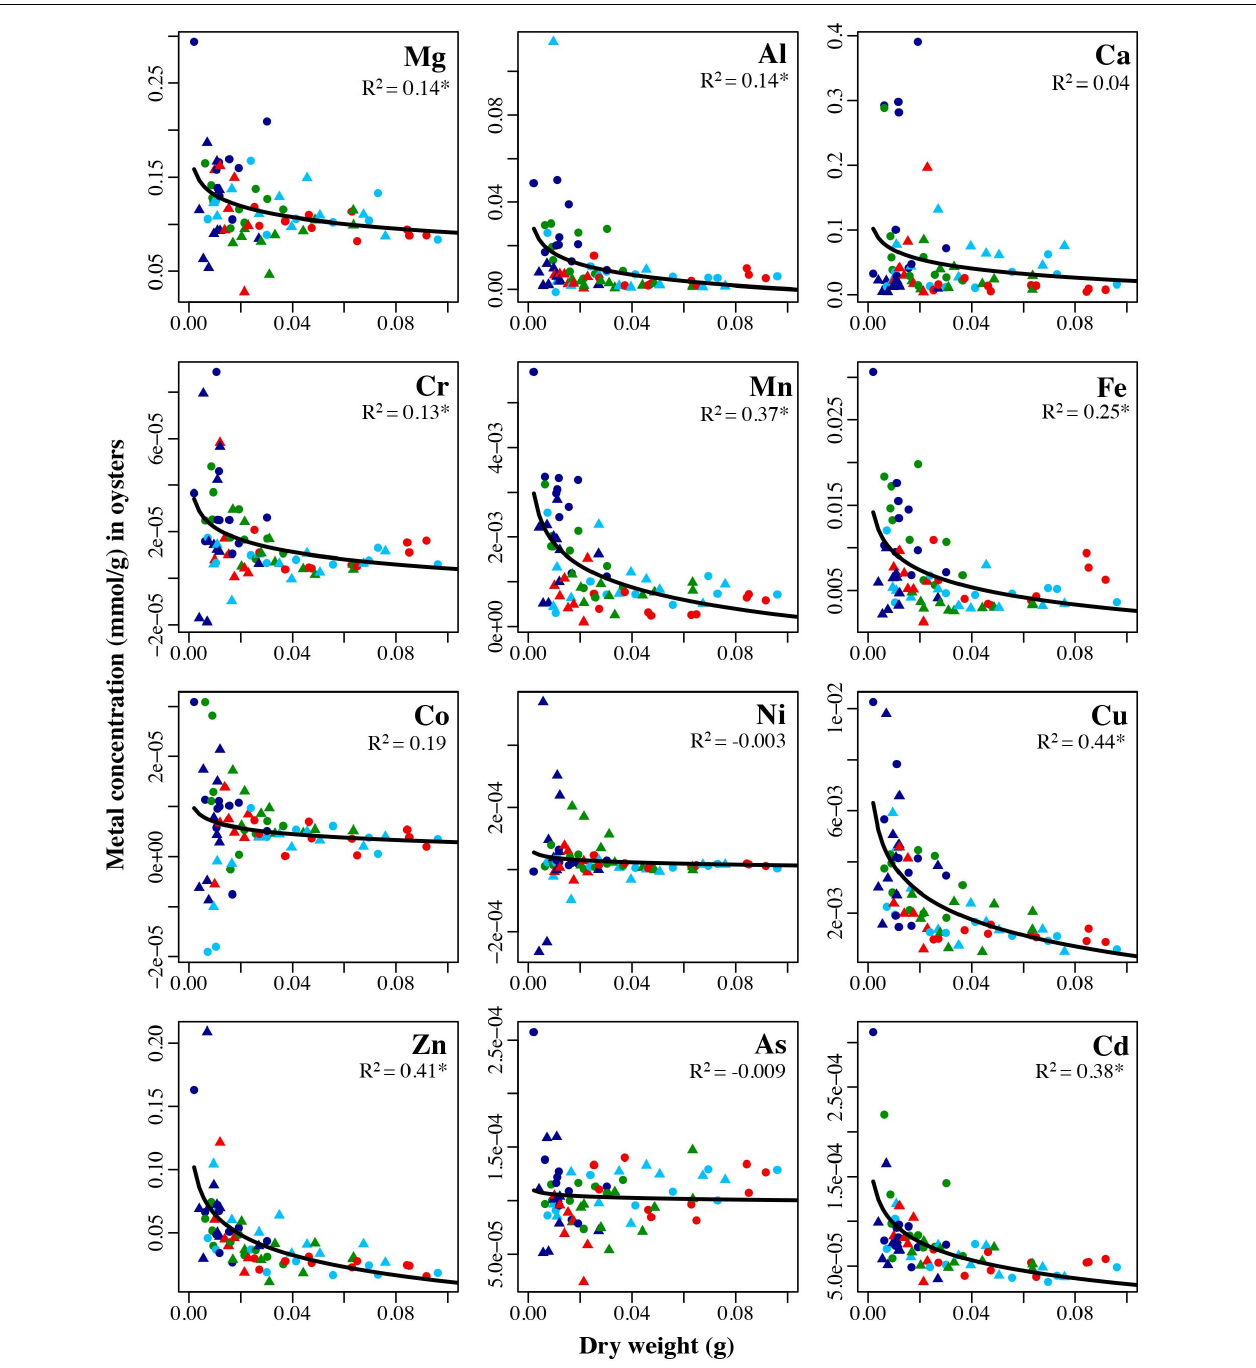
FIGURE 10 | Concentrations in mmol/g for each of the twelve analyzed trace metals in oysters held for 6 months (January: circles) and 1 year (July: triangles) in four locations: Point Wells 5 m (green), Dabob Bay 5 m (red), Carr Inlet 5 m (light blue), and Carr Inlet 20 m (dark blue), all plotted against the dry weight (grams) of the oysters. Adjusted R 2 values from exponential regression are shown in each panel. Asterisk indicates the R 2 value is significant after Bonferroni correction (alpha of